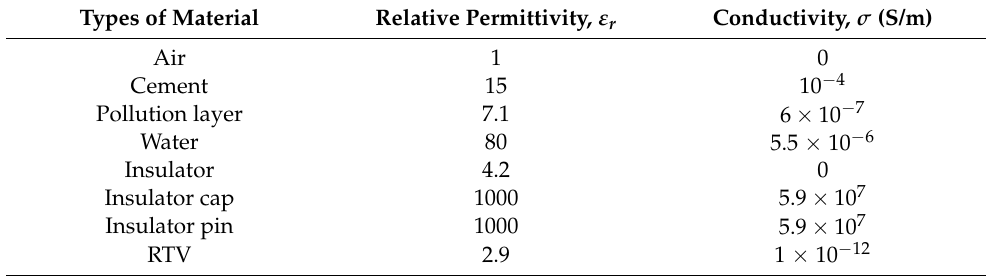
Table 5. Material properties.